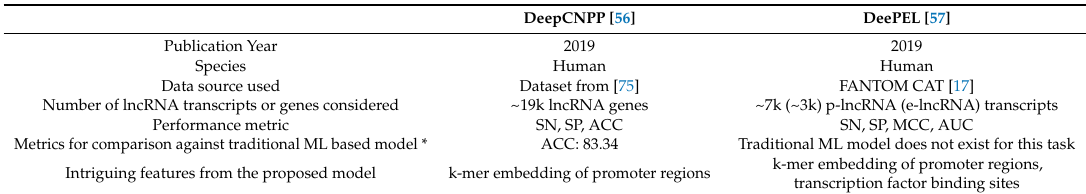
Table 3. Overview of articles for demystifying transcription regulation of lncRNA leveraging DL-based